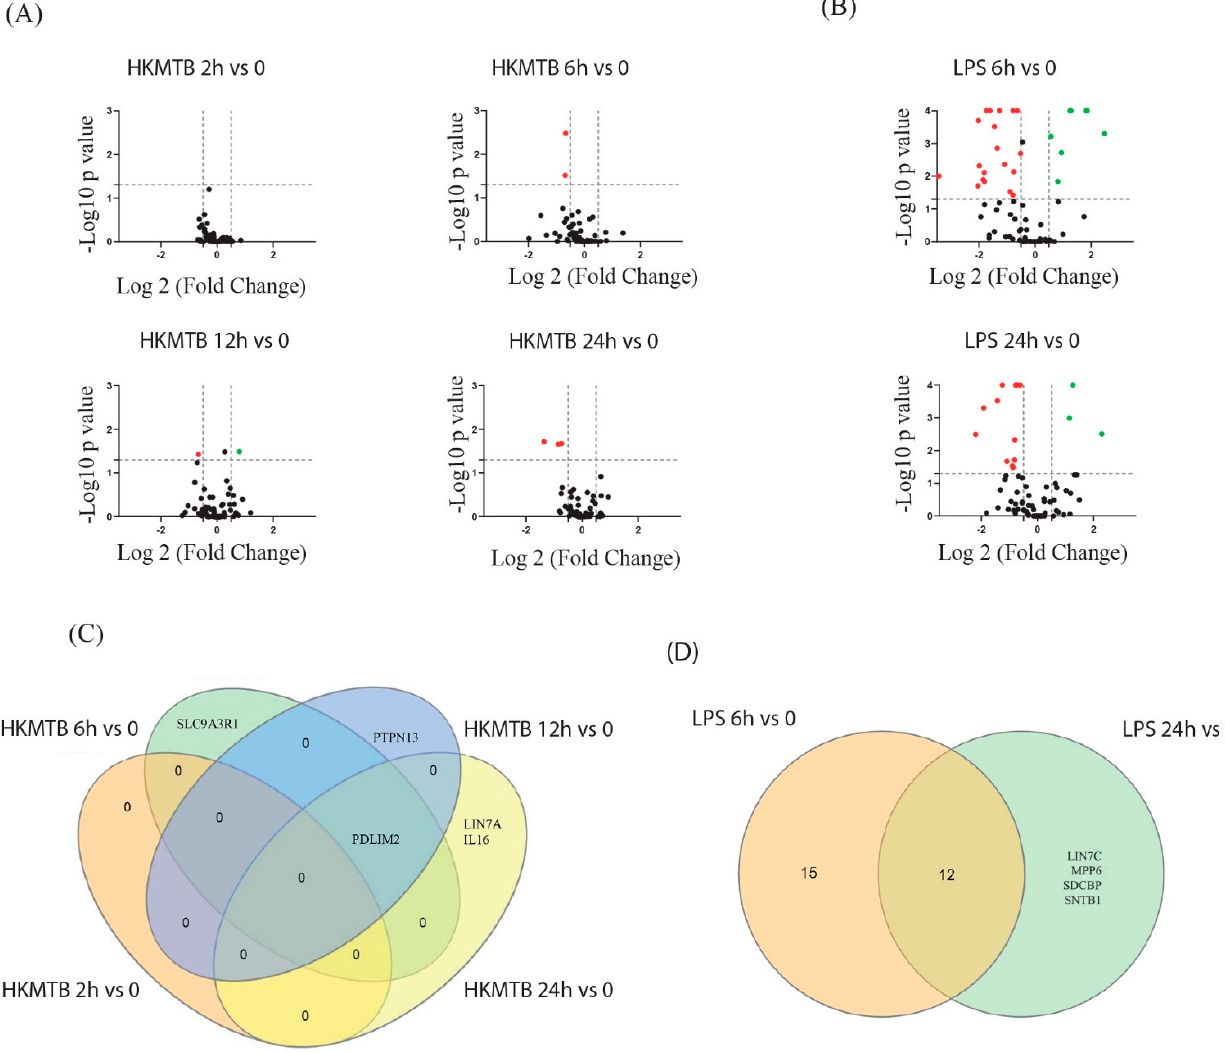
Figure 4. Differentially expressed PDZ genes in M ɸ stimulated with HKMtb and LPS at different time points. Volcano plots of DEGs in M ɸ at 2, 6, 12, and 24 h post–stimulation with HKMtb ( A ) and 6 and 24 h post–stimulation with LPS ( B ) compared to baseline expression in unstimulated M ɸ . Data are shown as the mean of log 2 fold change subjected to Dunnett’s comparison (x–axis); log 2 fold change ≥ 0.5 (green dots) or ≤ –0.5 (red dots) are considered significant. The y–axis represents –log 10 of the p –value; statistical significance was set at p < 0.05. Venn diagrams show DEGs comparison during time course stimulation with HKMtb ( C ) or LPS ( D ) in M ɸ . The set of DEGs is listed in Supplementary Table S5.